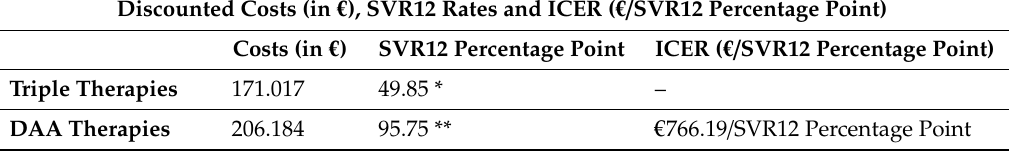
Table 4. Cost e ff ectiveness.